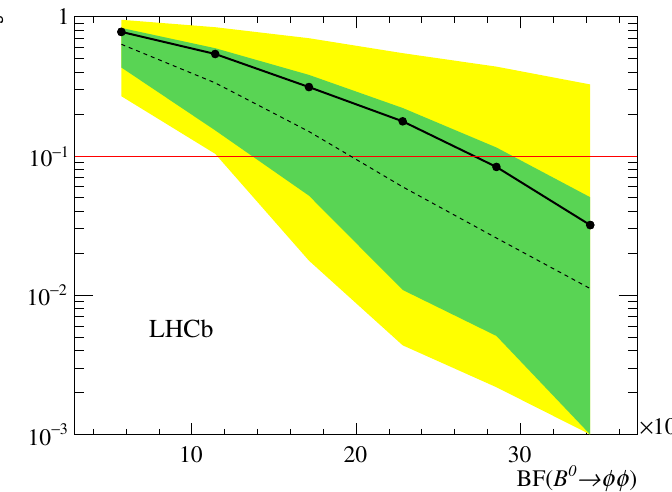
Figure 7 . Results of the CL s scan as a function of the B 0 ! (cid:30)(cid:30) yield. The solid black line shows the observed CL s distribution, while the dotted black line indicates the expected distribution. The green (yellow) band marks the 1 (cid:27) (2 (cid:27) ) con(cid:12)dence region on the expected CL s . The 90 % CL limit is shown as a red